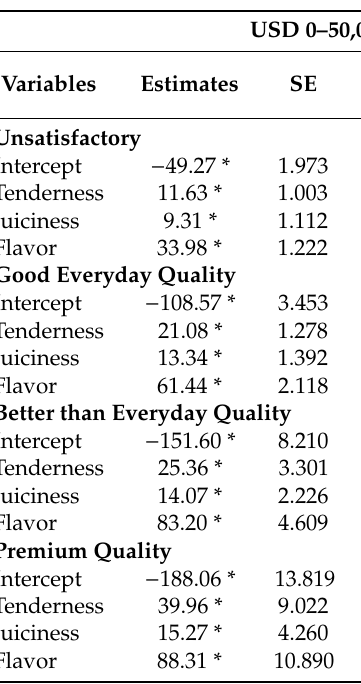
Table 12. Comparison of attribute intensity for income groups by satisfaction